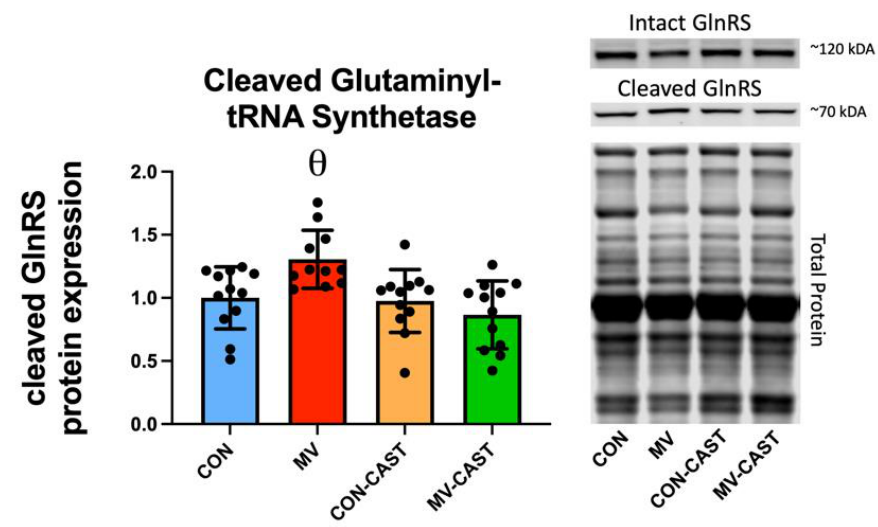
Figure 4. MV-induced activation of calpains results in increased cleavage of glutaminyl tRNA synthetase (GlnRS). θ = MV is significantly different from CON, CON-CAST, and MV-CAST.